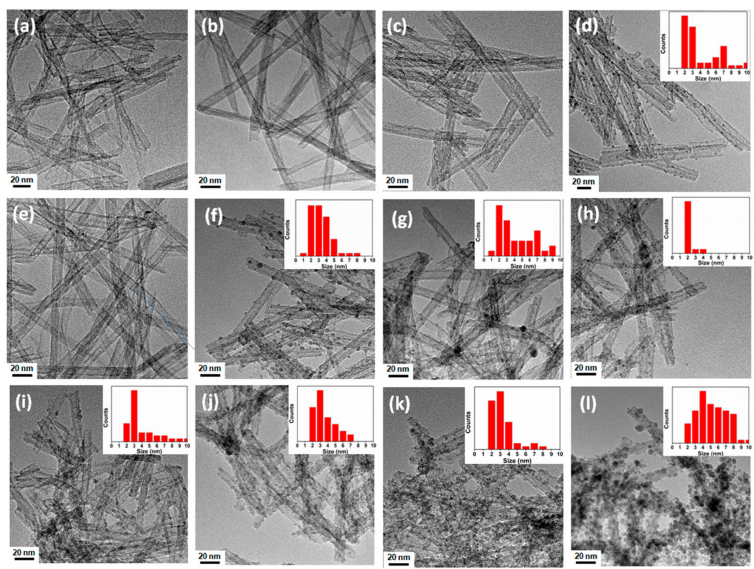
Figure 1. TEM images of Ag / TNTs and size distribution (inserted) of Ag nanoparticles (NPs) on TNTs: ( a ) Ag / TNT-1_SH, ( b ) Ag / TNT-5_SH, ( c ) Ag / TNT-2.5_AM, ( d ) Ag / TNT-100_AM, ( e ) Ag / TNT-2.5_IN, ( f ) Ag / TNT-100_IN, ( g ) Ag / TNT-2.5_NB, ( h ) Ag / TNT-100_NB, ( i ) Ag / TNT-2.5_EL (0.1), ( j ) Ag / TNT-100_EL (0.1), ( k ) Ag / TNT-2.5_EL (1), ( l ) Ag / TNT-100_EL